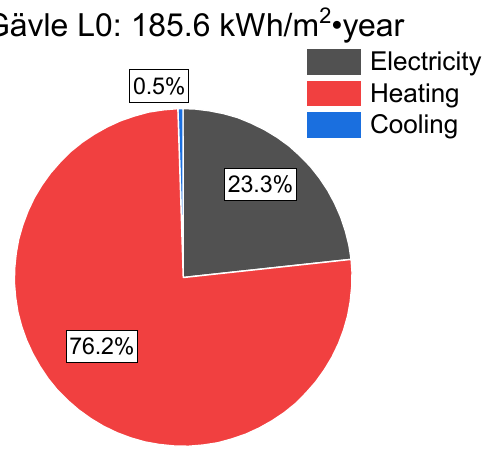
Figure 14. Breakdown of building’s annual energy usage for